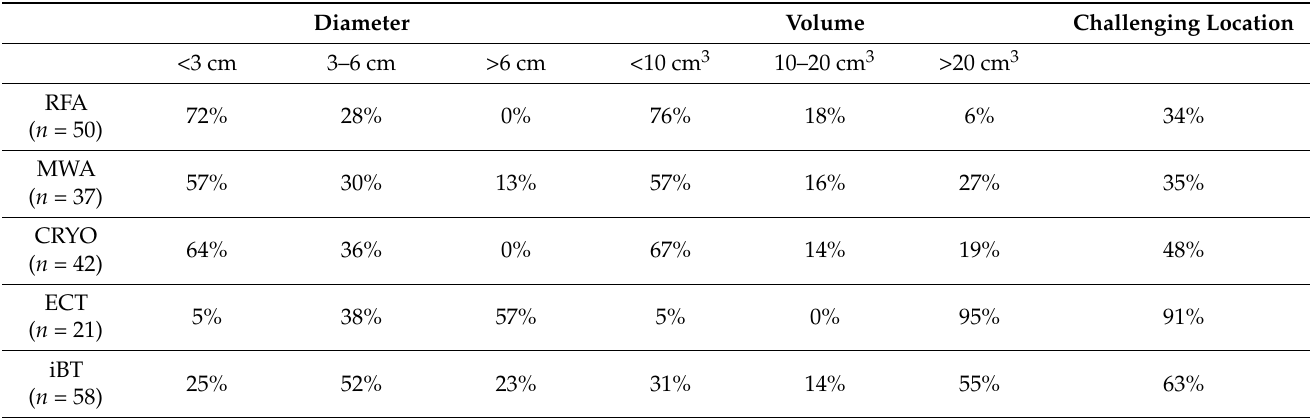
Table 2. Patient selection. Proportionate distribution of maximum lesion diameters, volumes and proportion of lesions in challenging locations tabulated and sorted by ablation procedure.